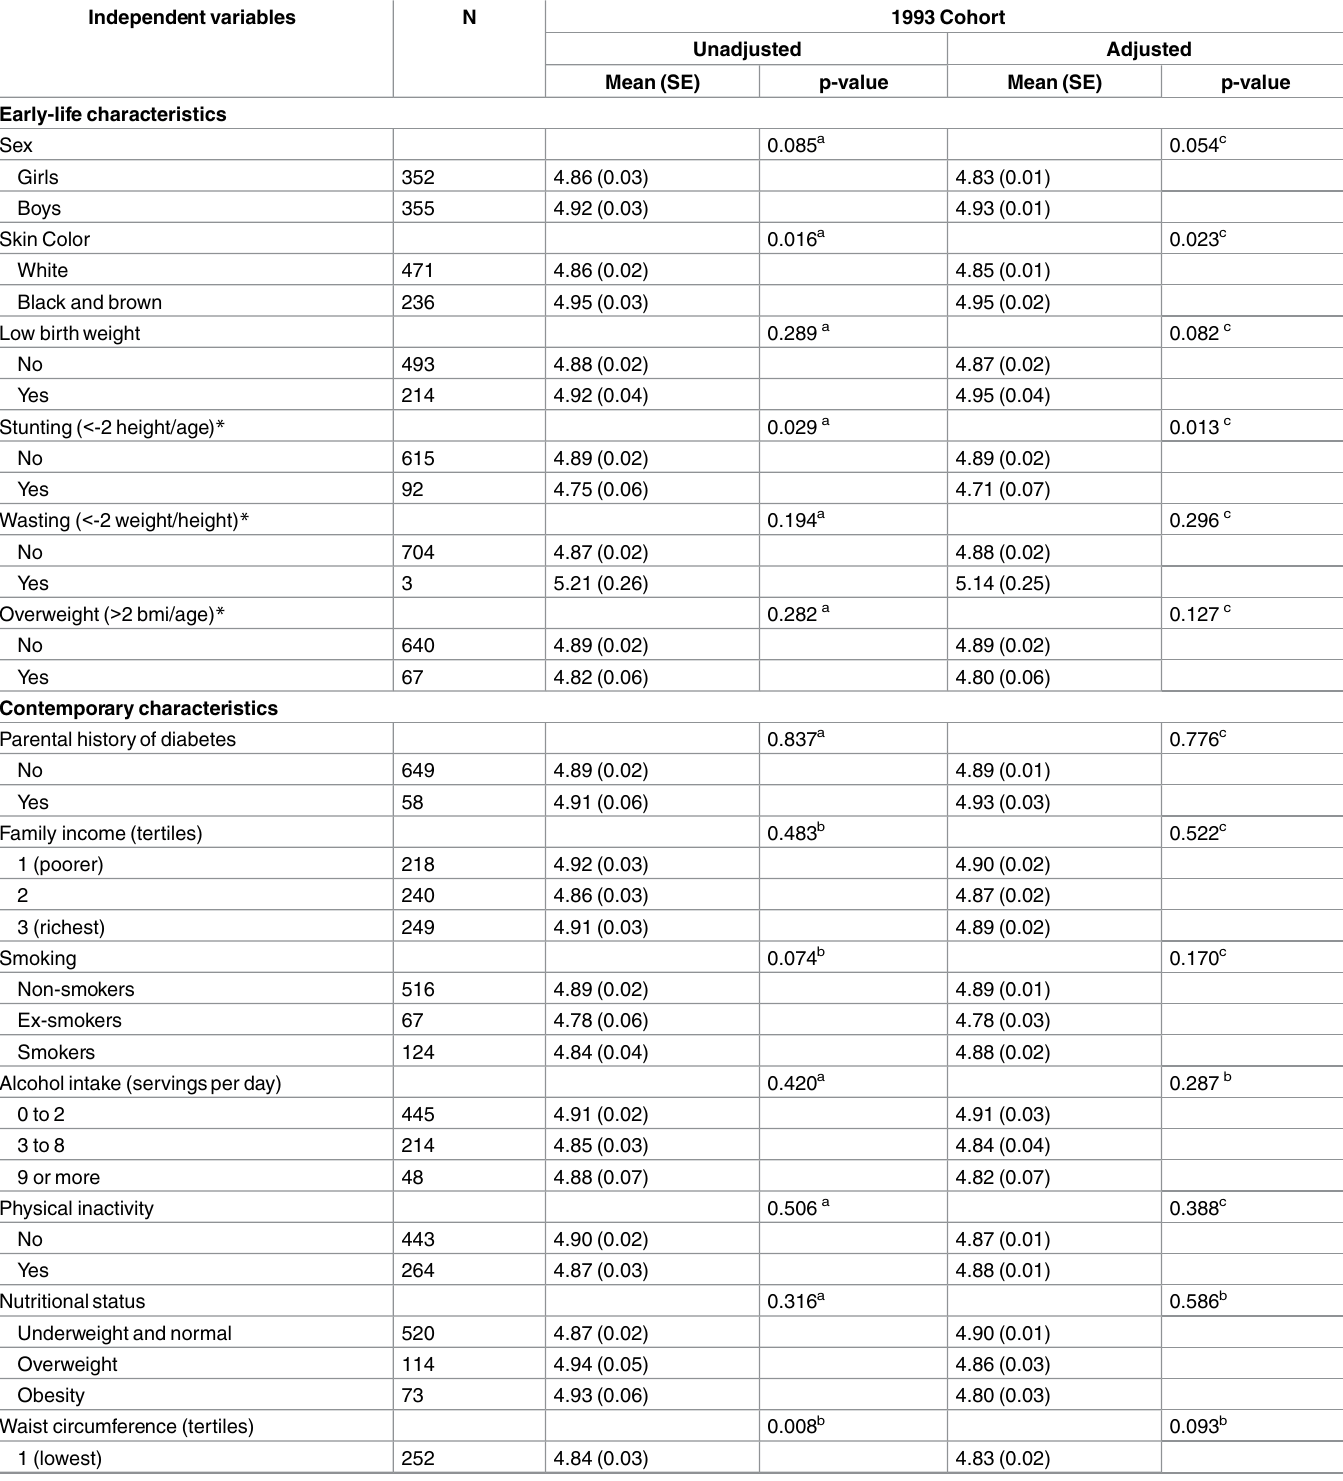
Table 3. Unadjustedand adjusted mean and SE for HbA 1c according to early-life, demographic, socioeconomicand behavioral factors,parenthis- toryof diabetes, nutritionalstatusand waistcircumferenceamongadolescents in the 1993 Pelotas